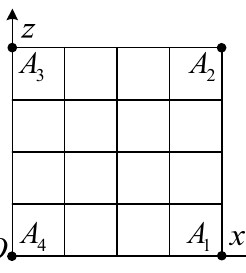
Figure 3. Layout of the connection point for the capture and lock mechanism on the bottom of the payload.